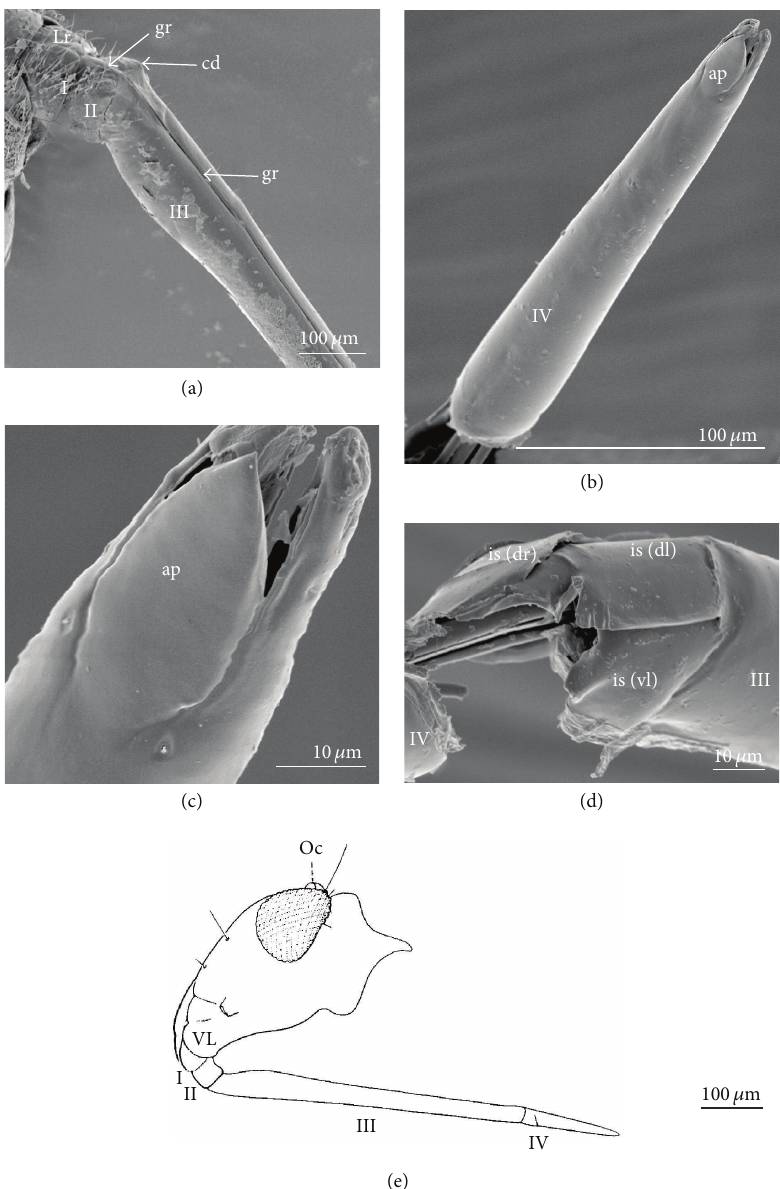
Figure 2: Characters of the labial segments of the Mesovelia (Gerromorpha). (a) Shapes of segments: first (I) is ring shaped, well visible from the dorsal side, the second (II) is similar to the first but slightly shorter, and the third (III) is tubular and very long. (b) The fourth segment is tubular, ventral view. (c) The shape of the ventral apical plate (lobe shaped). (d) Shapes of the intercalary sclerites (three large sclerites are visible: dorsal right (is (dr), left (is (dl), and ventral left (is (vl)). (e) The complete view of the labial segment of Mesovelia mulsanti (drawing from Andersen